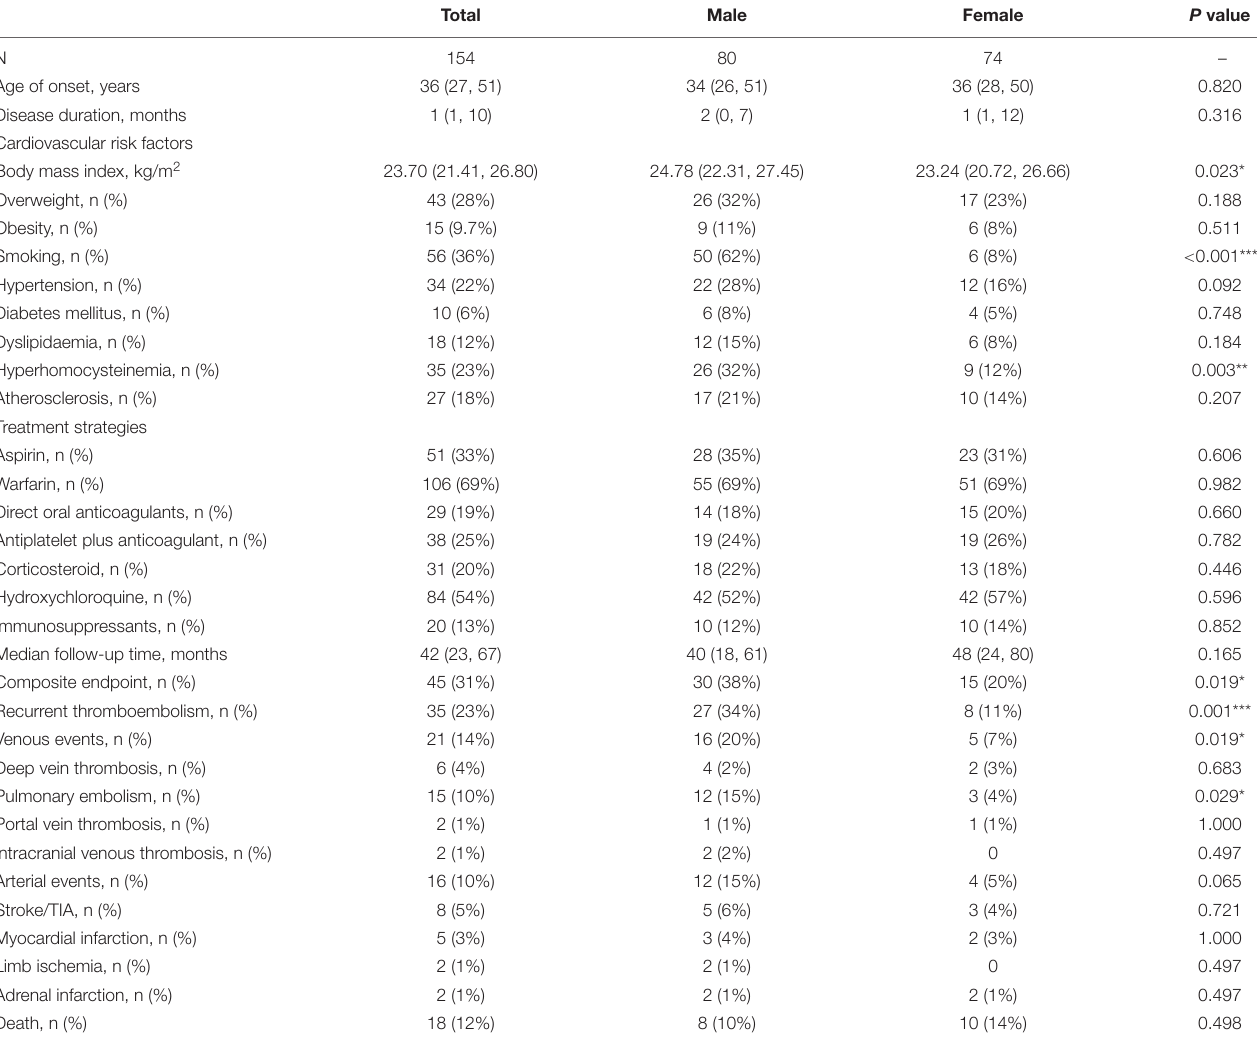
TABLE 1 | Demographic characteristics, treatment, and follow-up of patients with primary thrombotic antiphospholipid syndrome (ptAPS). Total Male